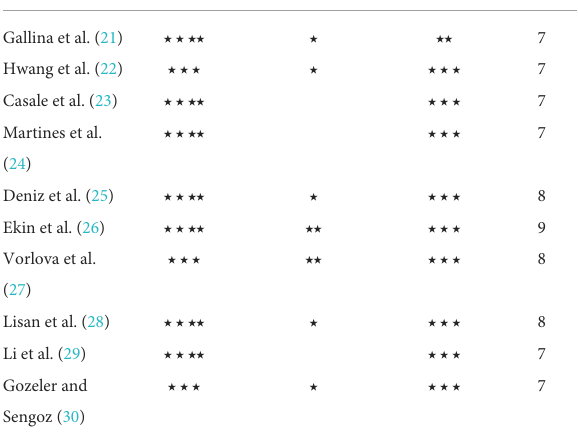
TABLE 2 Newcastle–Ottawa scale of the included